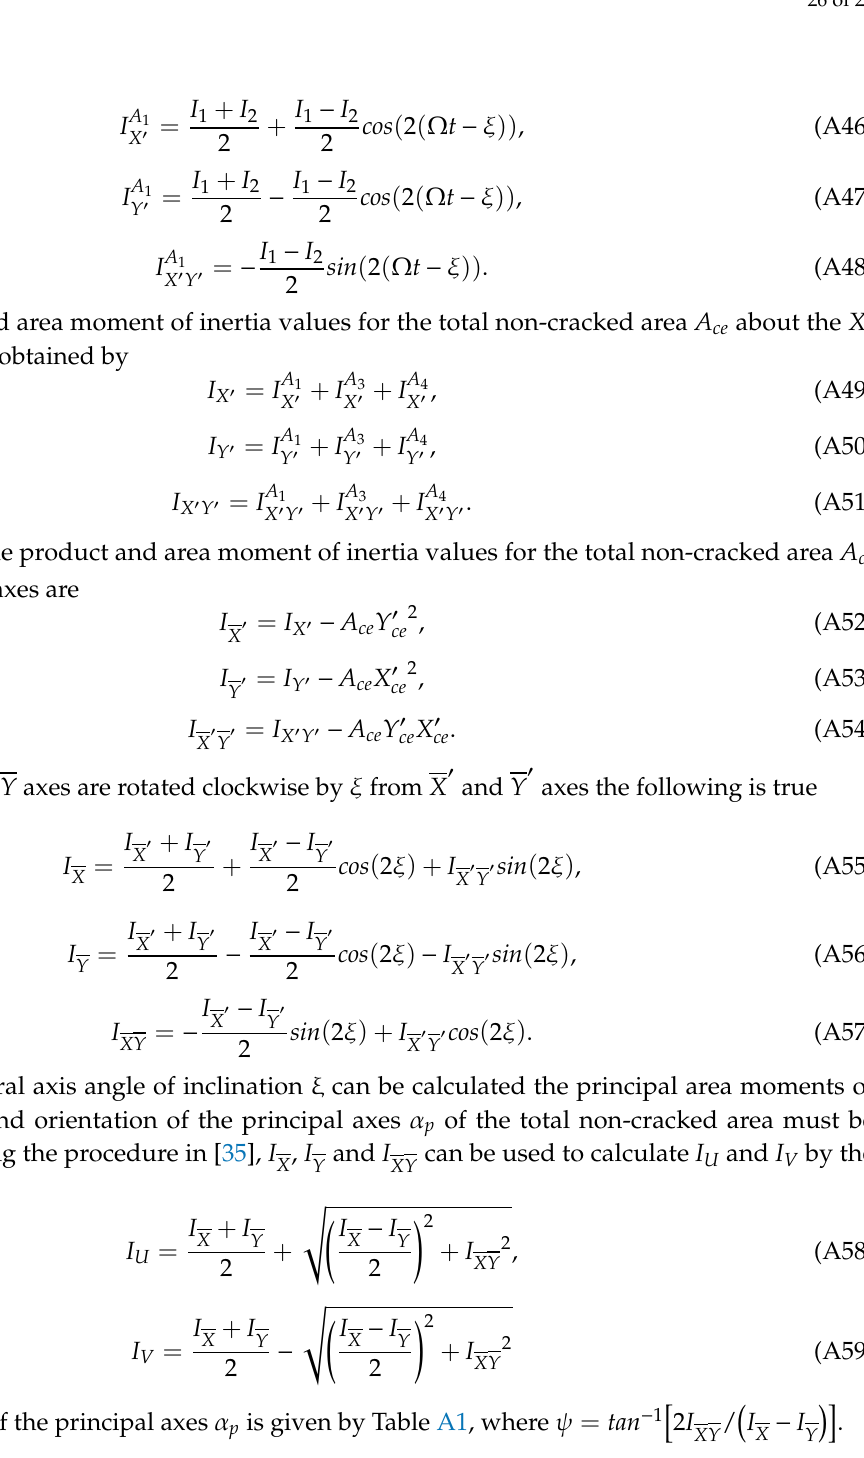
Table A1. Value of α p based on centroidal area moments of inertia of total non-cracked cross section. Value of α p Condition